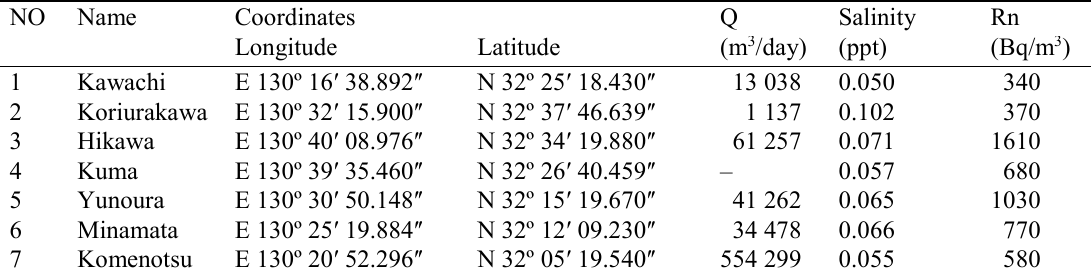
Table 1 Location and results of measurements of the studied